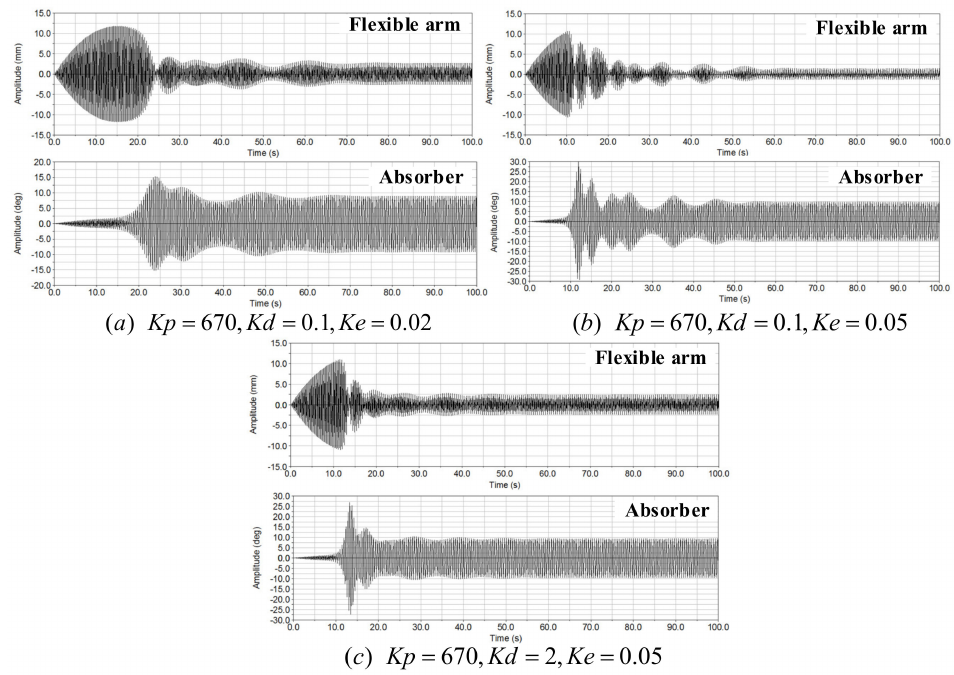
Figure 13. Effect of Ke on saturation amplitude of the flexible manipulator and vibration absorber.